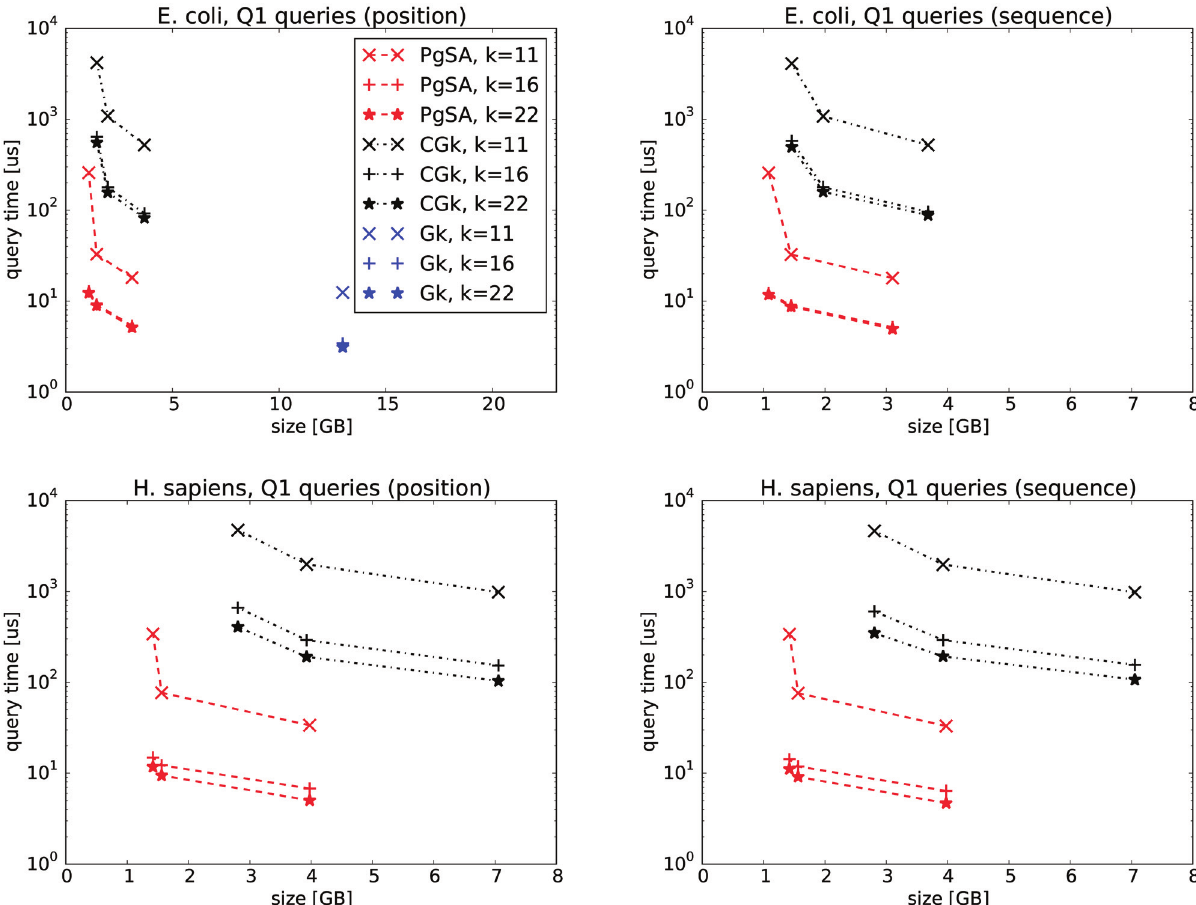
Fig 2. Q 1 query results on E. coli (top row) and H. sapiens (bottom row) data. The three points in PgSA series correspond to sparsity s = 6 for the leftmost point, s = 3 (E. coli) or s = 4 (H. sapiens) for the middle point and s = 1 for the rightmost point. The three points in CGk series correspond to sampling rates sr of 512, 25 and 6 (E. coli), and 512, 22 and 6 (H. sapiens), respectively. On the left figures the query is given as a position in the read list, while on the right ones as a